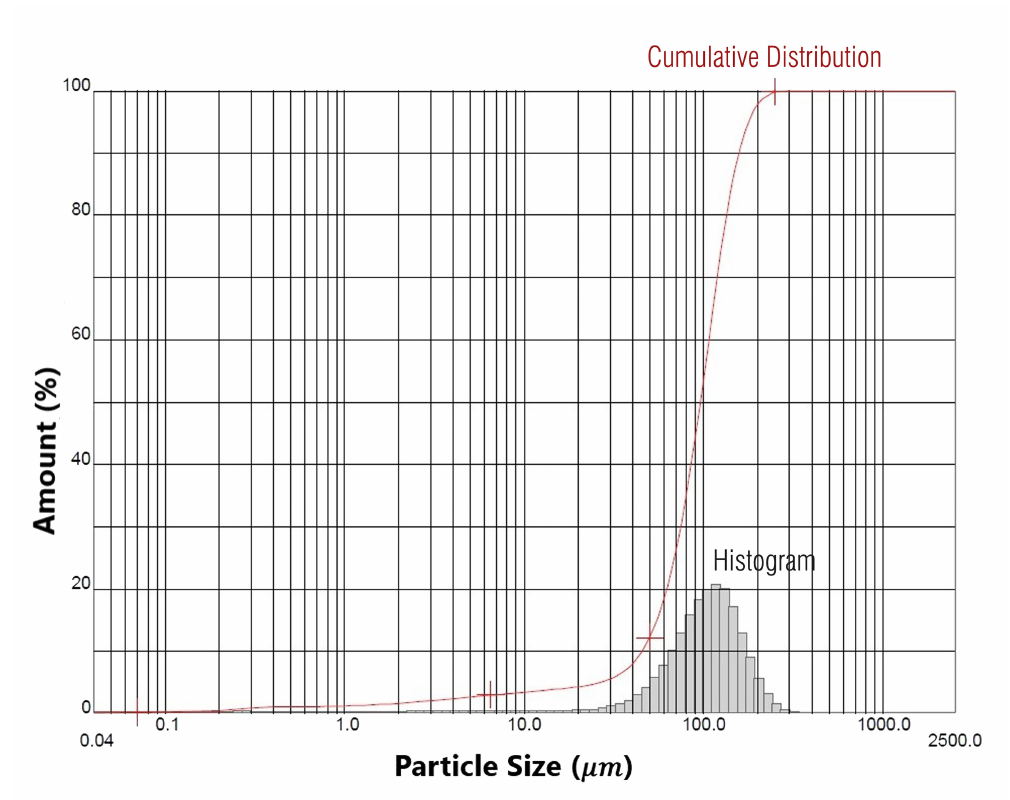
Figure 2. Particle size distribution of aluminium oxide and cumulative distribution.